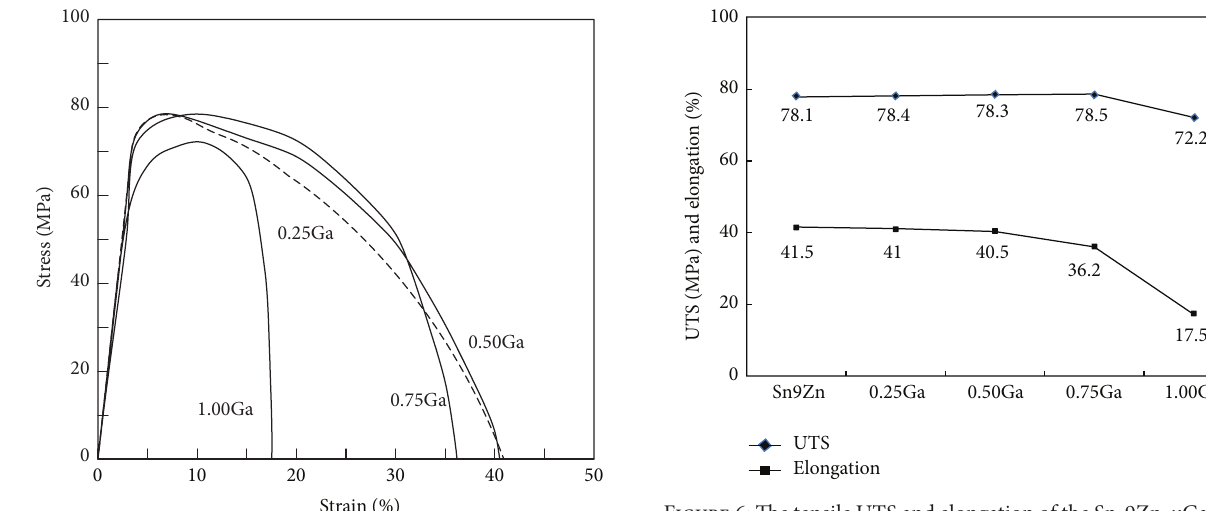
Figure 6: The tensile UTS and elongation of the Sn-9Zn- 𝑥 Ga alloys as a function of Ga